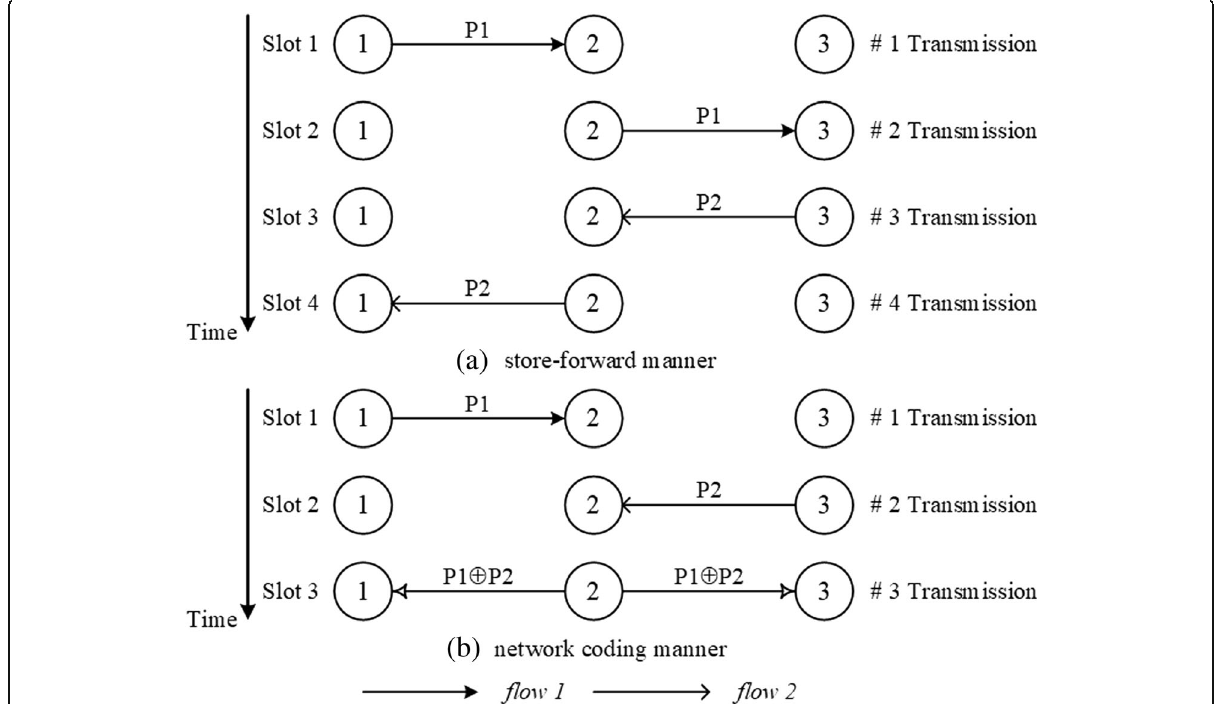
Fig. 1 Network Coding VS. Store Forward Manner. Figure 1 depicts the advantage of ( a ) network coding vs. traditional ( b ) store forward manner in reduction of transmission, through a scenario with three nodes, in which two nodes want to exchange packets through the intermediate